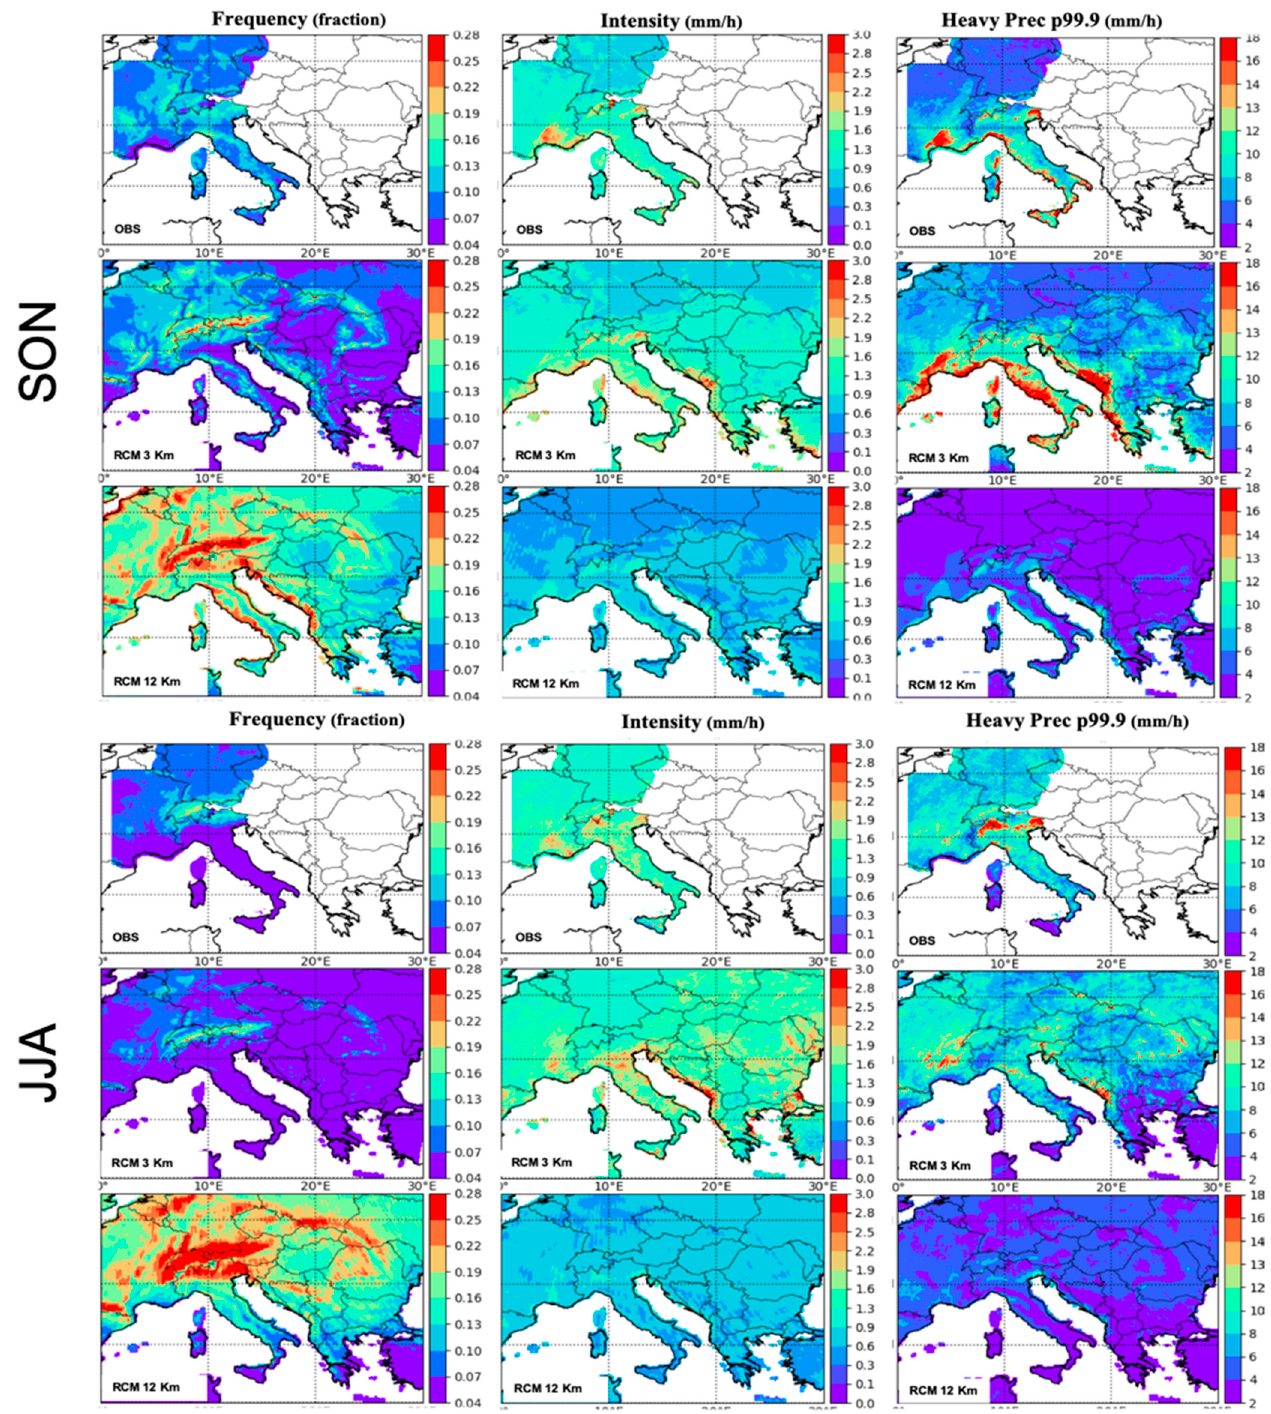
Figure 7. Similar to Figure 6, but for hourly precipitation. The observations are composed from available gridded hourly precipitation over Switzerland [74], France [8], Italy [76], and Germany [77]. Heavy hourly precipitation is defined as the 99.9th percentile of all hourly events. Some biases can be found in CP-RegCM4-NH, such as an overestimation of precipi- tation intensity and heavy precipitation (p99) in SON, particularly over the orographical peaks, and an underestimation of frequency and mean seasonal precipitation in JJA. Con- versely, the RegCM4-NH run shows an overestimation of frequency, an underestimation